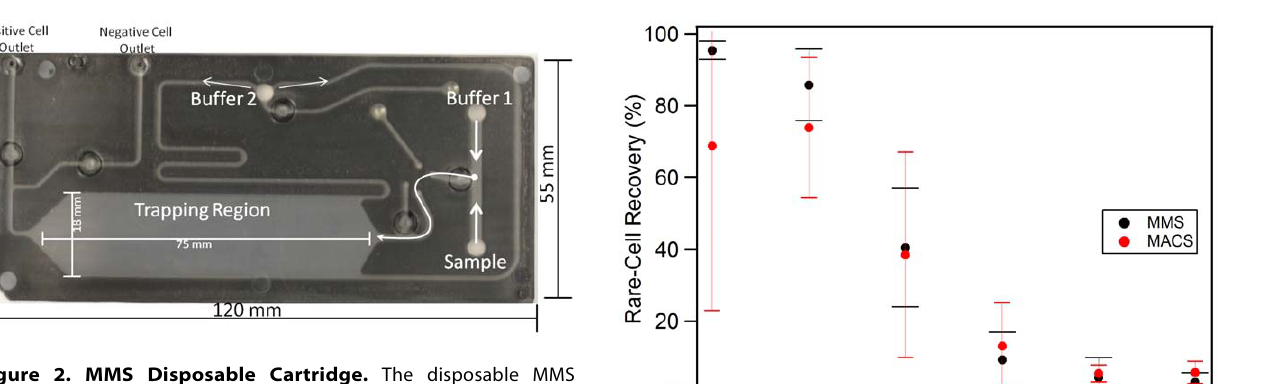
Figure 2. MMS Disposable Cartridge. The disposable MMS cartridge is made from polypropylene with outer dimensions of 120 mm 6 55 mm. The sample is mixed with buffer 1 prior to entering the trapping region. Buffer 2 is used to wash away all of the cells not bound to magnetic beads in the trapping region, which are collected at the negative cell outlet. Buffer 2 is also used to elute the cells trapped on the magnetic beads into the positive cell outlet for overnight growth for subsequent sorting or analysis of the enrinched population. Figure 3. Rare-cell and Ultra-rare Cell Recovery Comparison.